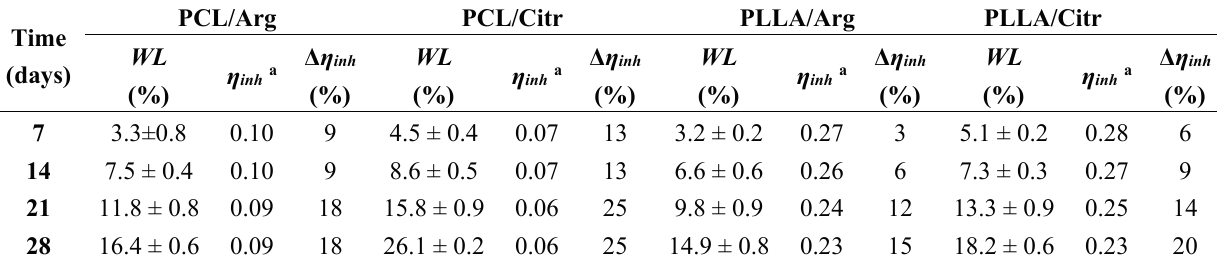
Figure 7. Effect of hydrolytic biodegradation time on the WL of polymeric matrices. Table 3. The hydrolytic degradation results of the synthesized polymeric matrices.